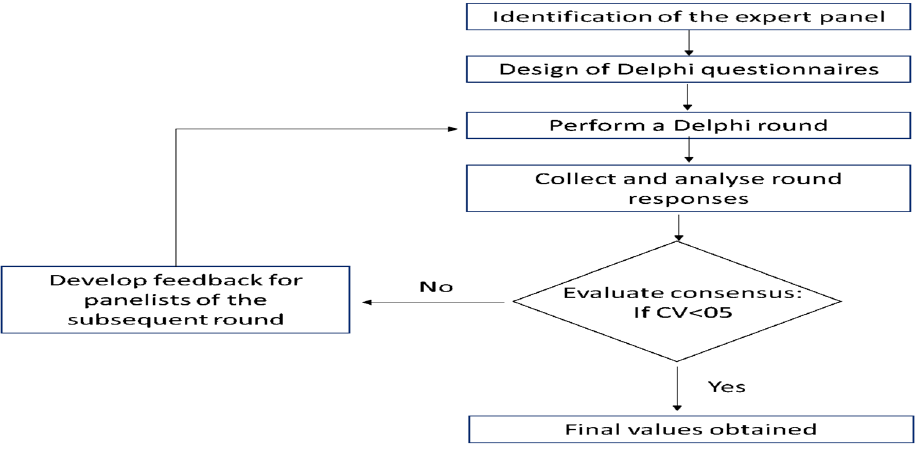
Figure 2. Flowchart of the Delphi methodology for obtaining consensus weights.